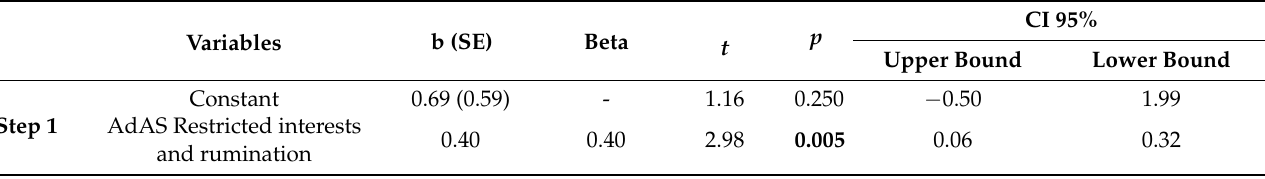
Table 4. Stepwise linear regression with Suicidality score as a dependent variable and AdAS Spectrum domains as independent variables in the BD group.